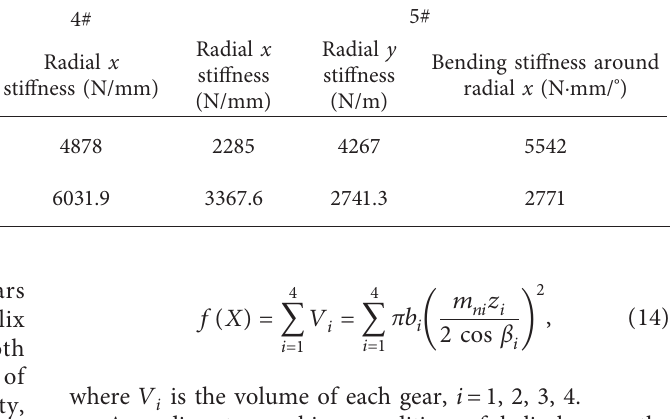
Table 10: Optimization result of bushing stiffnesses.